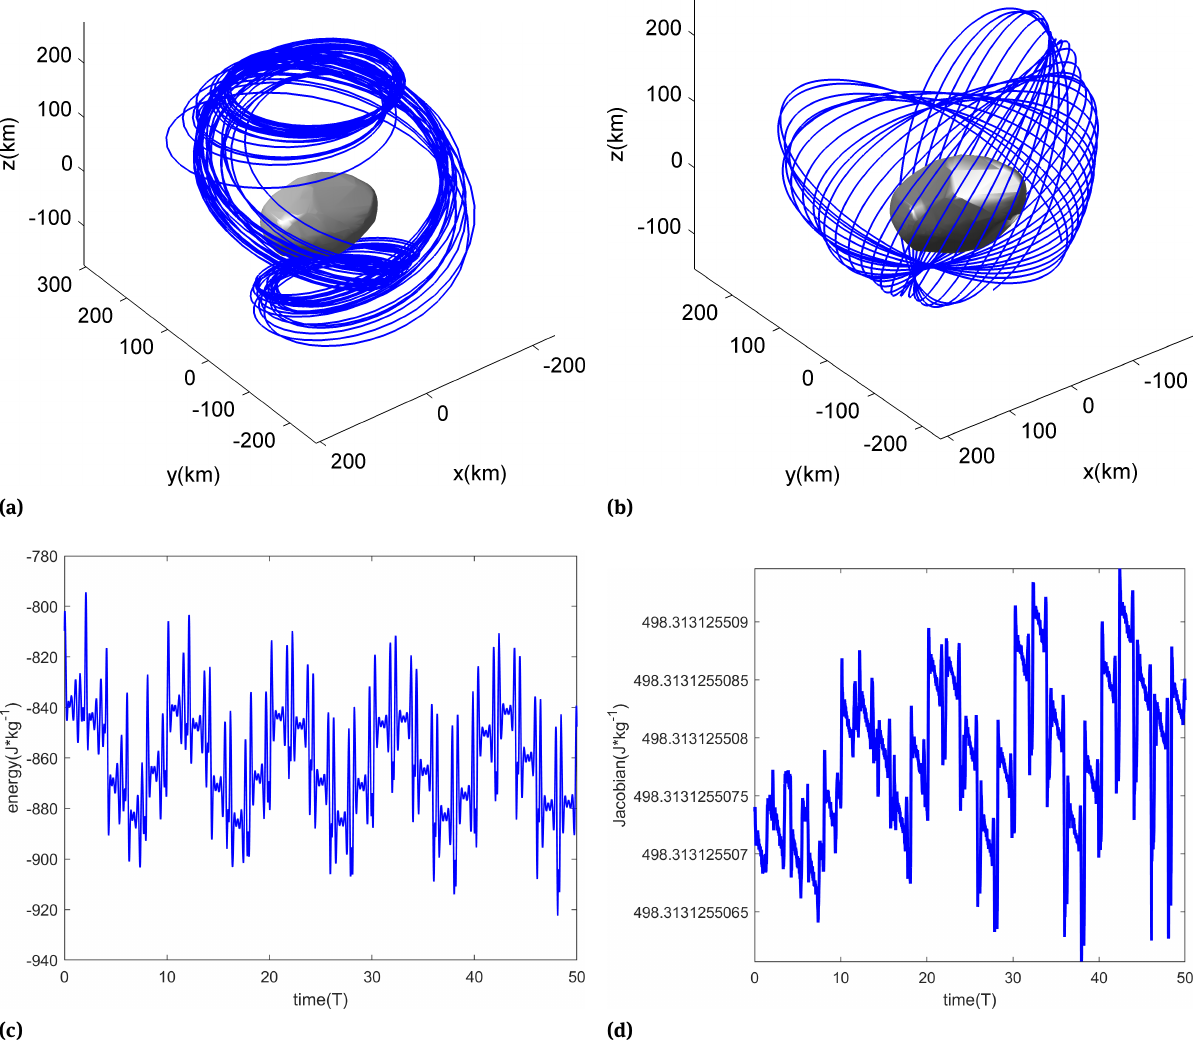
Figure 8. Perturbation of a periodic orbit in the potential of the asteroid Kalliope. (a) 3D plot of the orbit in the body-fixed frame. (b) 3D plot of the orbit in the inertia system. (c) Mechanical energy of a particle in the periodic orbit. (d) Jacobian of a particle in the periodic orbit.